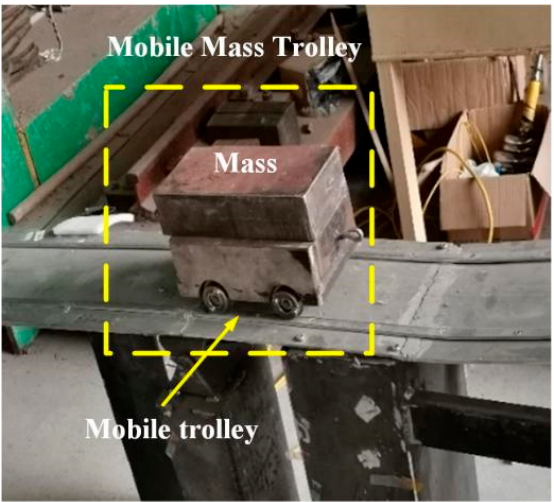
Figure 5. Mobile trolley.